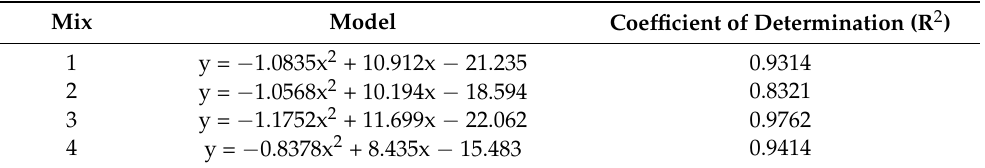
Figure 10. Relation between the compressive strength of the different mixes samples with the compressive strength of the control samples. Table 10. Mathematical models relating UCS of samples from different mixtures and UCS of control samples at different curing ages.